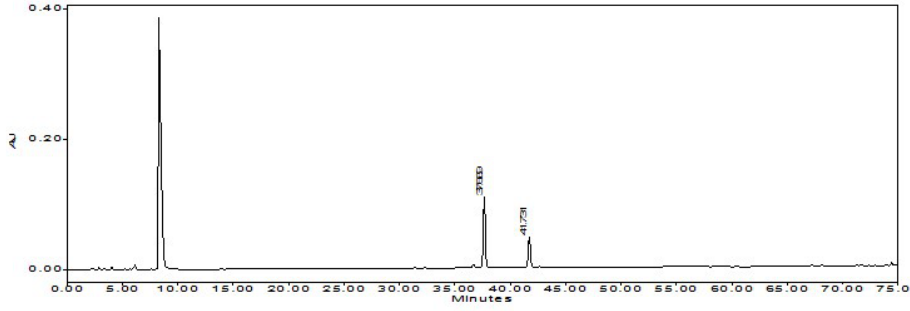
Figure 4. Chromatograms of capsaicinoids (Fraction A) and no-heat red pepper oil or NHRPO (Fraction B). The blue line indicates the percentage of ethanol in the aqueous mobile phase. The pink and red lines indicate the UV absorptions at 228 nm (for detection) and 300 nm (for monitoring), respectively.